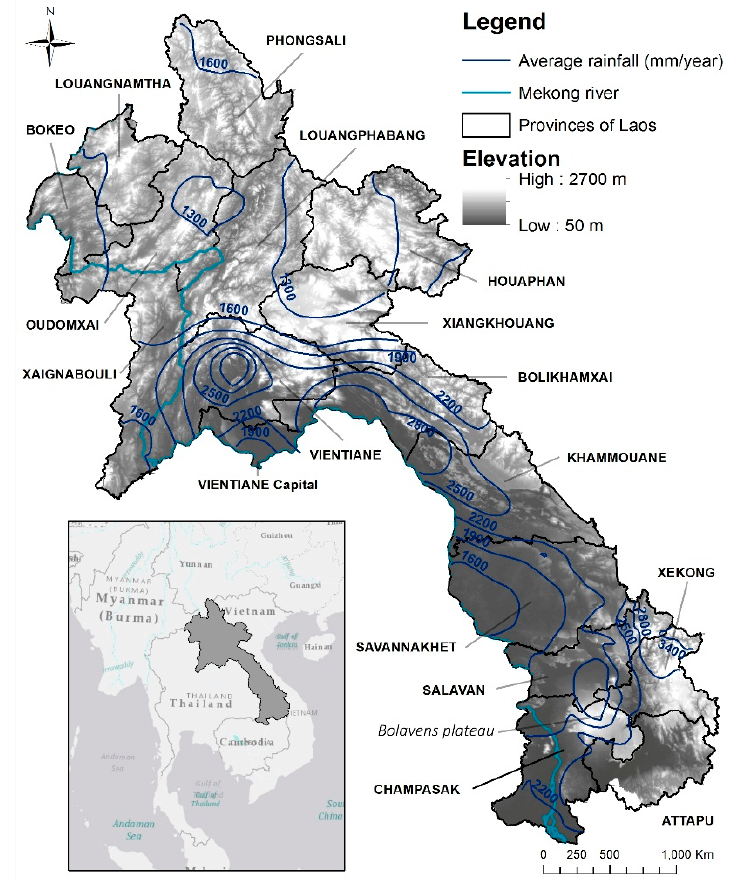
Figure 1. Topography—D.E.M: [23], indicative isohyets of annual average rainfall (CHIRPS data: [24]) and Provinces in Laos.